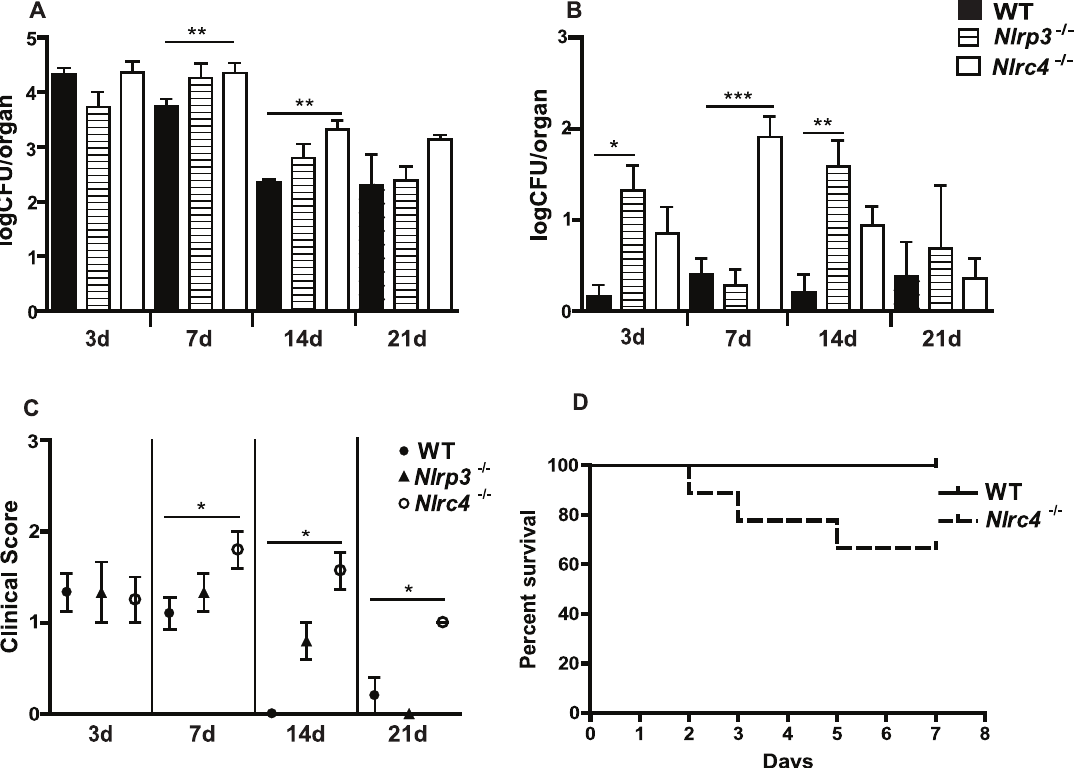
Figure 2. NLRC4 inflammasome protects against mucosal overgrowth and prevents systemic dissemination of infection with Candidaalbicans . (A) Quantitativefungal burdenof tongues, and(B)kidneys of Nlrp3 2 / 2 , Nlrc4 2 / 2 , andWT mice after oral infection with C. albicans ; (C) Mean clinical severity score of Nlrp3 2 / 2 , Nlrc4 2 / 2 , and WT mice after 3, 7, 14 or 21d of infection. (D) Kaplan-Meier survival curve of WT and Nlrc4 2 / 2 mice infected with virulent C. albicans. (*** P # 0.001; ** P # 0.01; * P # 0.05)